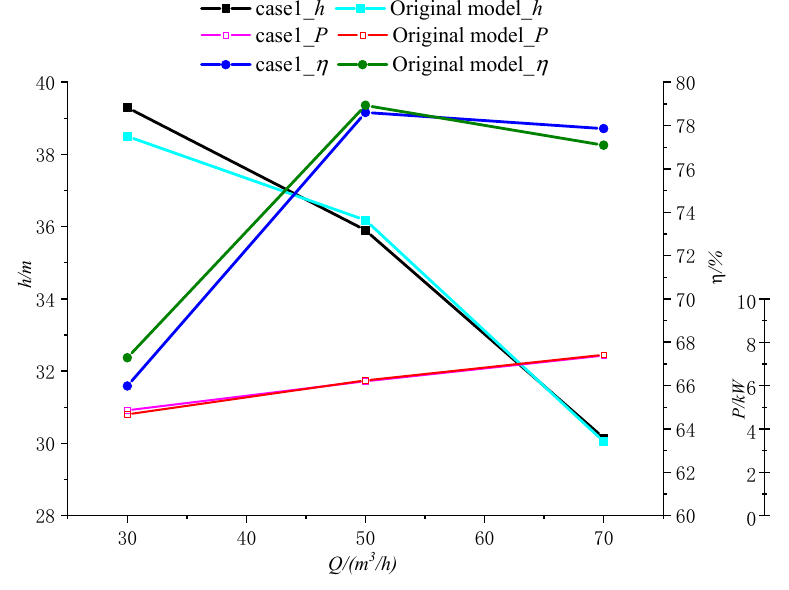
Figure 10. Comparison of case 1 and original model.